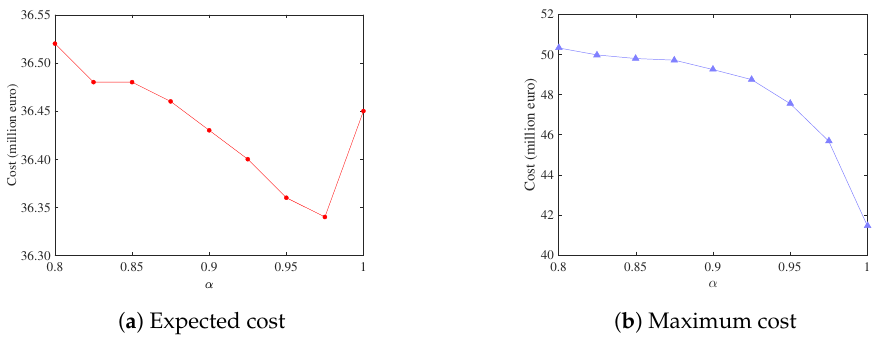
Figure 5. Maximum and expected total cost with respect to α .